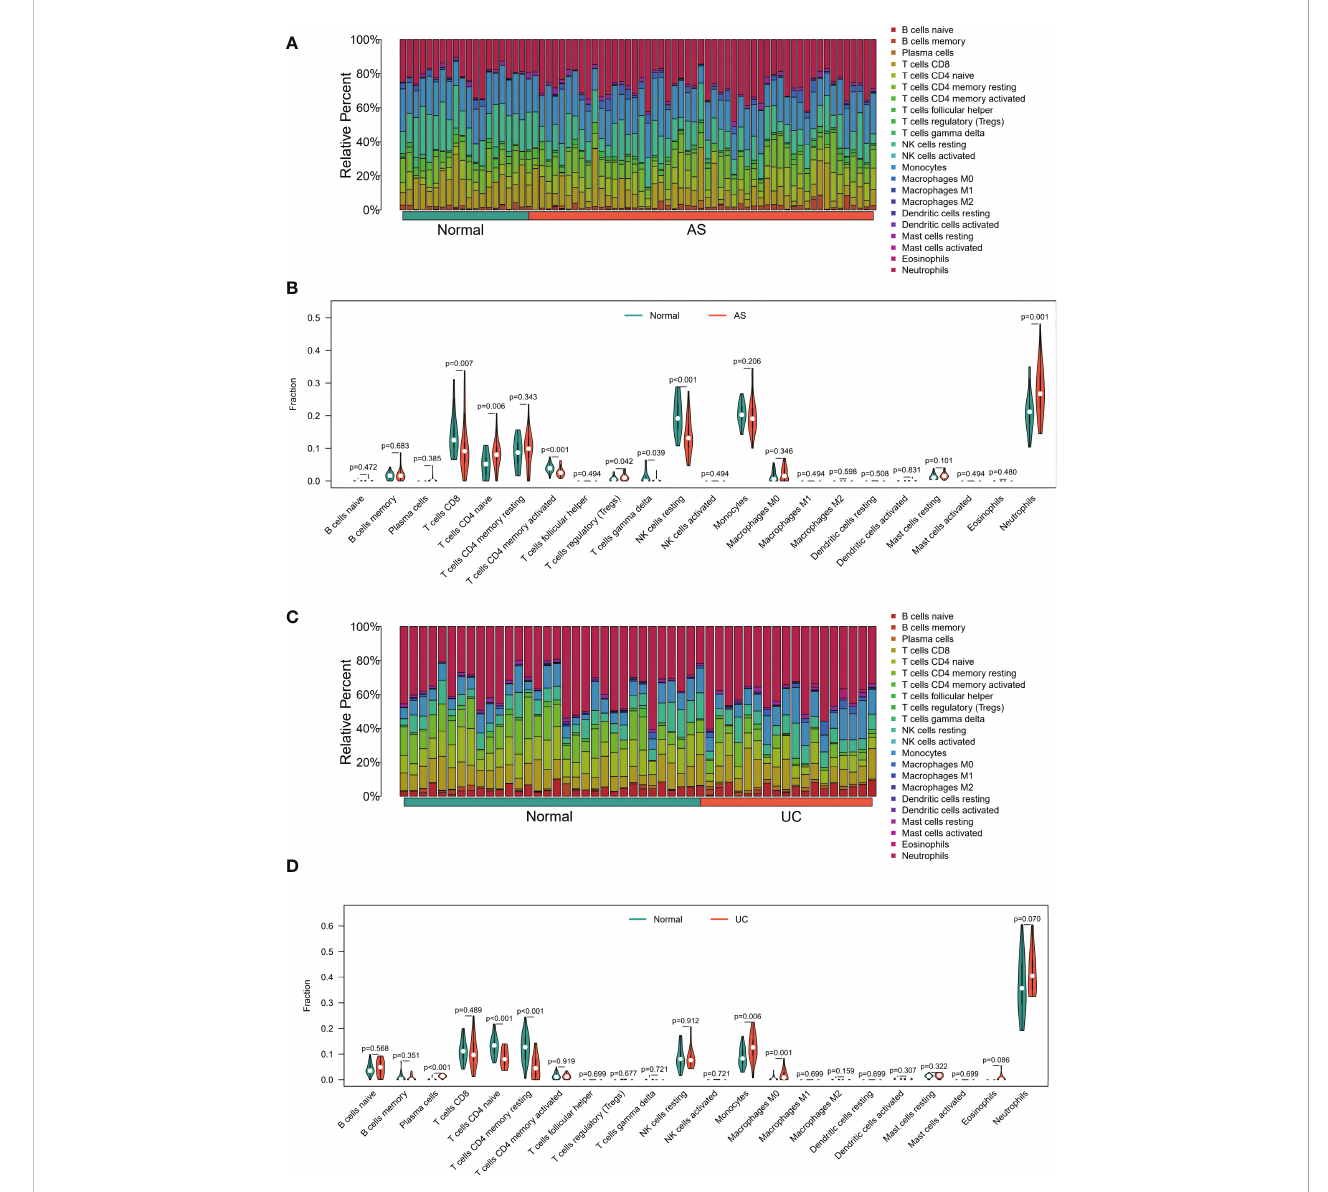
FIGURE 6 (A) The Bar plot of immune cell in fi ltration between AS and normal. (B) The Violin plot of the 22 types of immune cells proportions between AS and normal. (A, C) The Bar plot of immune cell in fi ltration between UC and normal. (D) The Violin plot of the 22 types of immune cells proportions between UC and